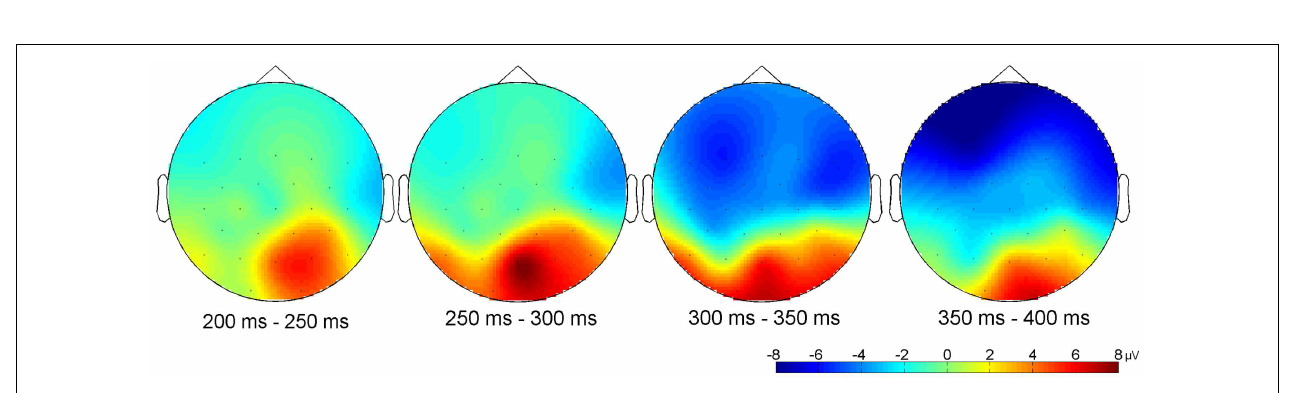
FIGURE 6 | Differential topographical map (asynchronous–synchronous trials) between 200 and 400ms after stimulus onset ( n = 15). Activity differences between the two stimuli emerged between 200 and 400ms at posterior sites and between 300 and 400ms at anterior electrodes.